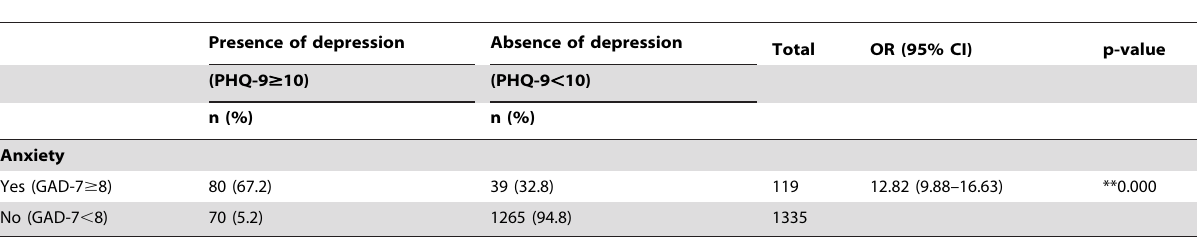
Table 3. Association of anxiety with depression among participants